Question: What kind of plot is shown here?
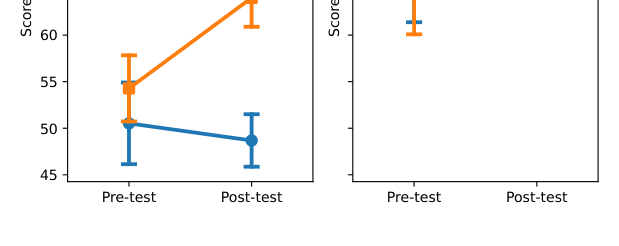
Answer: bar